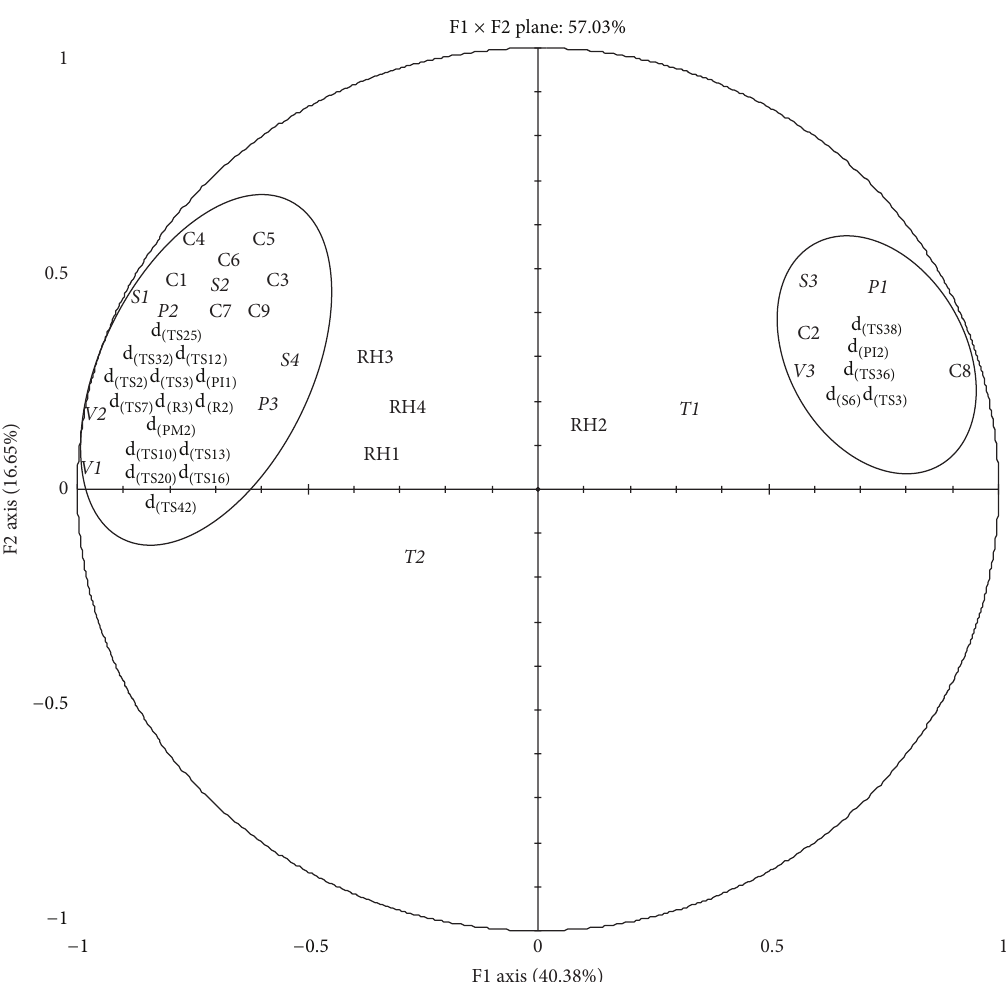
Figure 14: Projection of variables in the 1 × 2 factorial plane (representing 57.03% of the total variance) during the study period (threshold of significance = 0.5 for 𝑝 < 0.05 and 𝑛 = 9